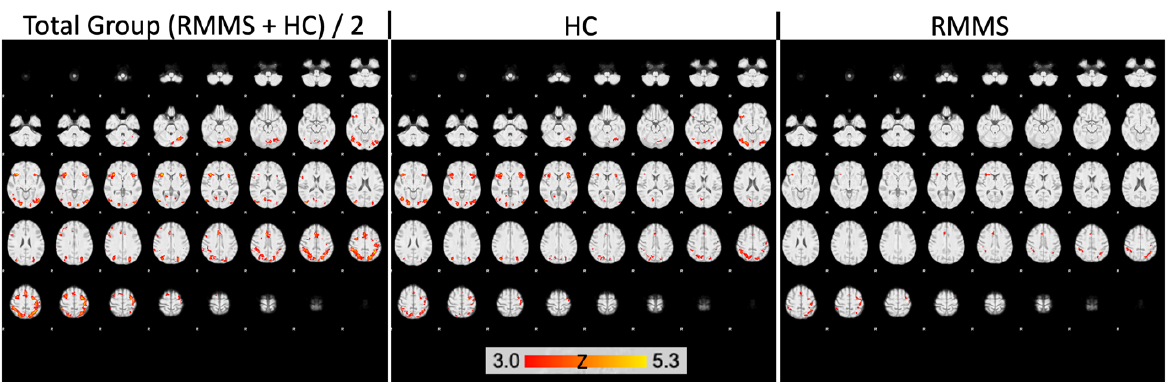
Table 5. Group differences in activation by ExecAttent in healthy controls (HC) and patients with RRMS. Results of permutation tests using threshold-free cluster enhancement. Clusters containing only voxels with pFWE < 0.05 and their maximum with MNI coordinates are shown. Bonferroni threshold is pB = 0.05/6 = 0.008 considering tests for six ROIs. p -values ≤ pB are marked with an asterix. All tests indicate higher activation in HC than in MS. Region Cluster Size (Voxels)